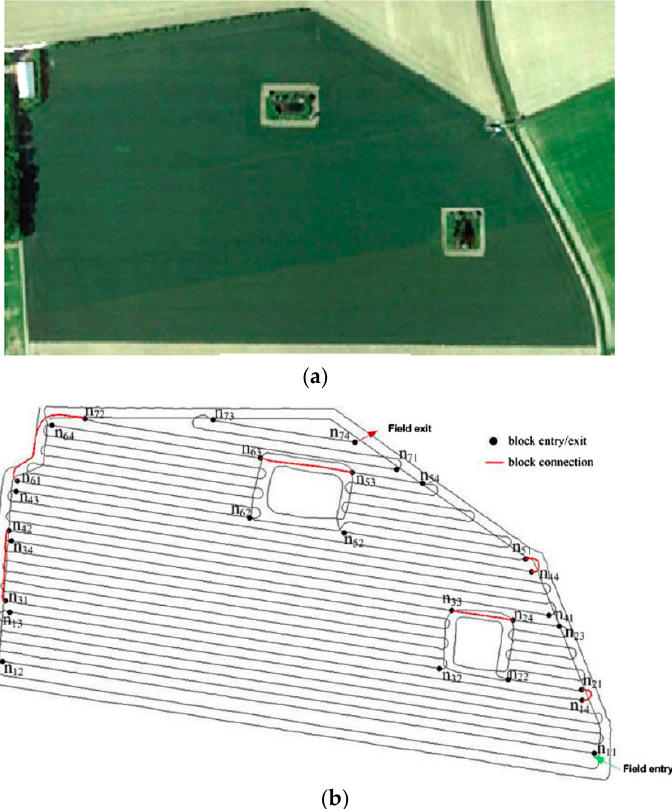
Figure 3 . ( a ) Selected field from satellite data; ( b ) the generated plan for the field [70].